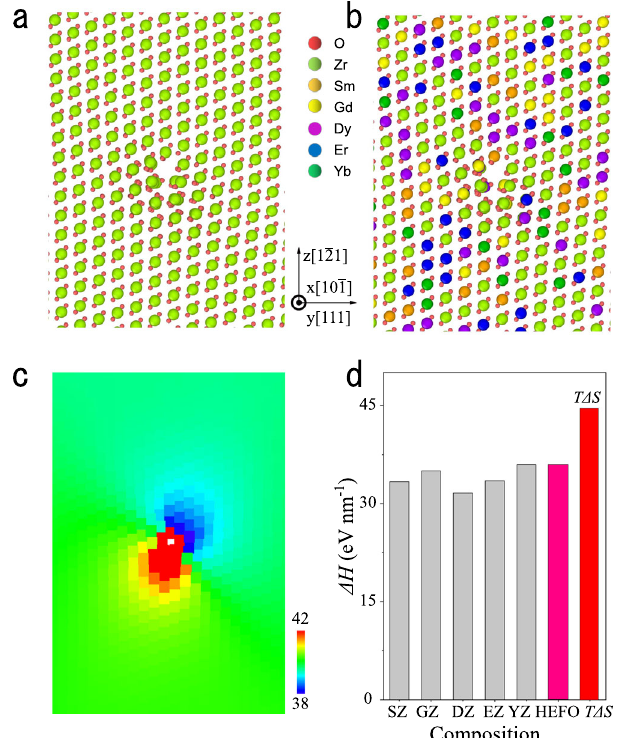
Fig. 2 The edge-dislocation model created for MD simulations. a Before doping with rare-earth ions; b After doping with rare-earth ions; c Voronoi atomic volumes distribution of the cations calculated by OVITO software (The color scale denotes the Voronoi volume of each cation (Å 3 )); d Enthalpy change of an edge dislocation compared with the value of “ T Δ S ” . (SZ, GZ, DZ, EZ, and YZ represent Sm 2 Zr 2 O 7 , Gd 2 Zr 2 O 7 , Dy 2 Zr 2 O 7 , Er 2 Zr 2 O 7 , and Yb 2 Zr 2 O 7